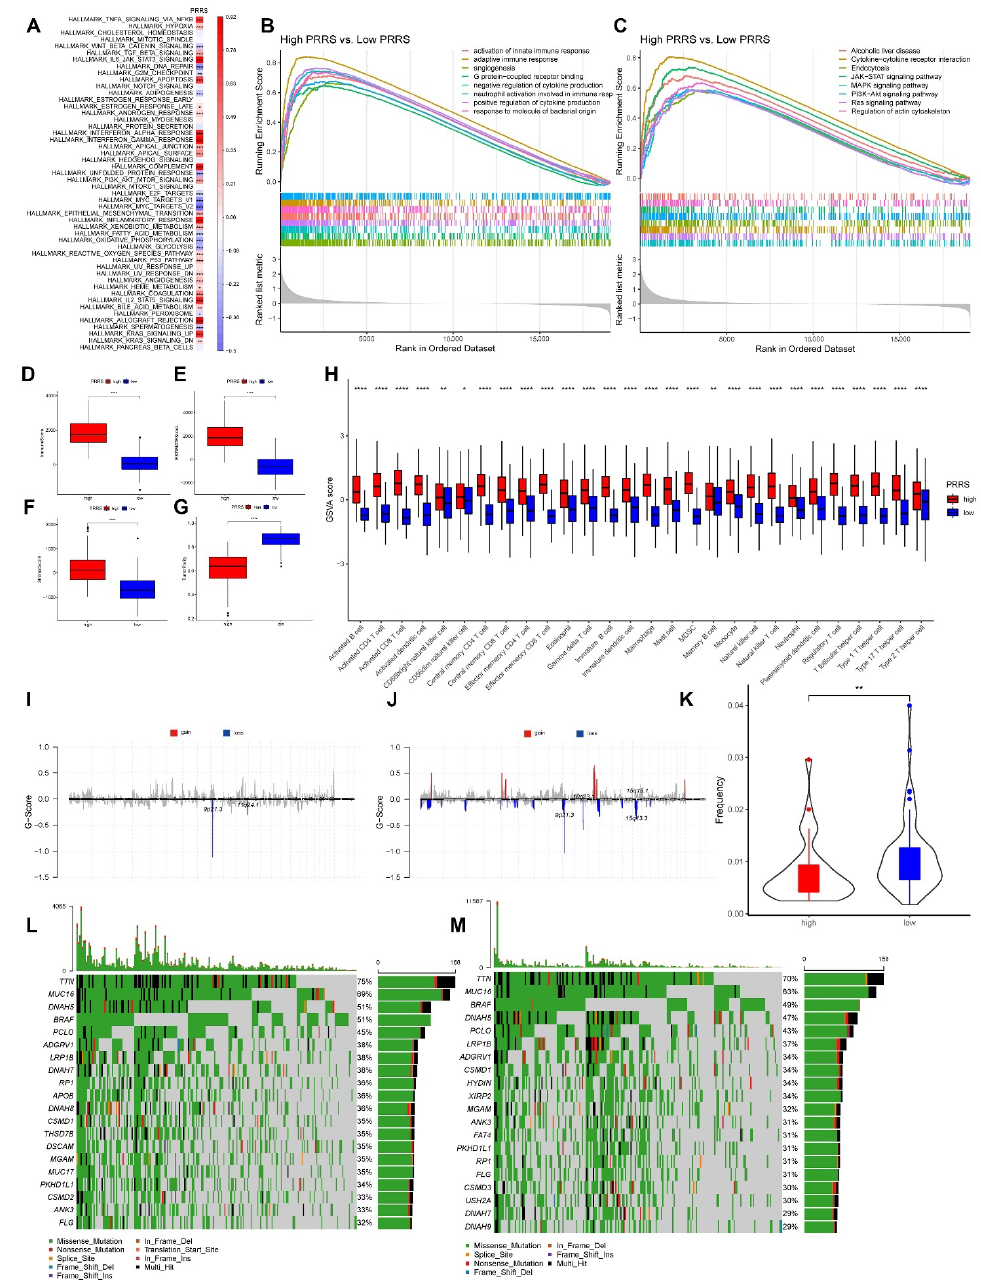
Figure 10. Analysis of the molecular mechanisms of different PRRS. ( A ) Correlation display of PRRS and hallmarks. Our results demonstrated that most of the pathways were significantly correlated with PRRS (* p < 0.05, ** p < 0.01, *** p < 0.001). ( B , C ) Functional differences between PRRS subgroups. ( B ) Display of GO function enrichment results for PRRS grouping. ( C ) Display of KEGG function enrichment results for PRRS grouping. ( D – H ) Differences in immune infiltrating cells between high and low PRRS subgroups (* p < 0.05, ** p < 0.01, **** p < 0.0001). ( D ) Differences in ImmuneScore in subgroups. ( E ) Differences in ESTIMATEScore in subgroups. ( F ) Differences in StromalScore in subgroups. ( G ) Differences in TumorPurity in subgroups. ( H ) Differences in immune-infiltrating cell enrichment scores between high and low PRRS subgroups were demonstrated. Our results